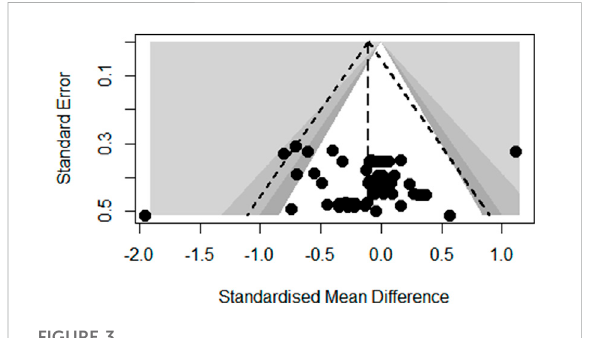
FIGURE 3 Funnel plot of body composition outcomes.